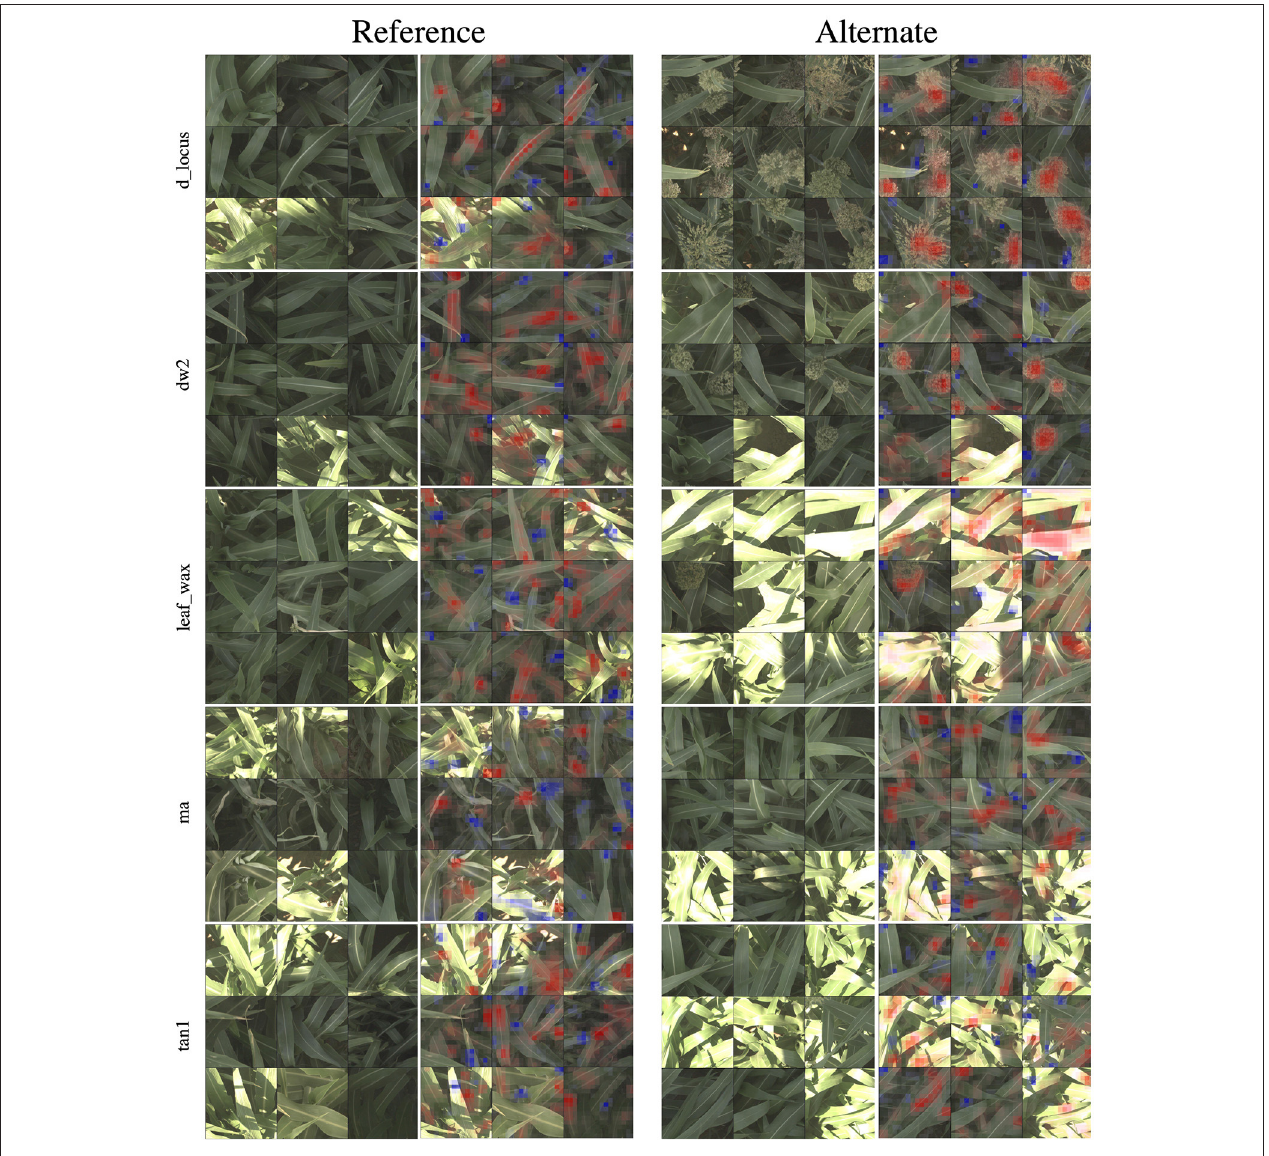
FIGURE 4 | For all five families of genetic markers, we can visualize highly activated and correctly classified images from the “reference” and “alternate classes,” and their corresponding classification visualization that highlights the features that led to the networks classification. Features highlighted in red are those that led the network to make its correct classification, while features in blue are those which detracted from the correct